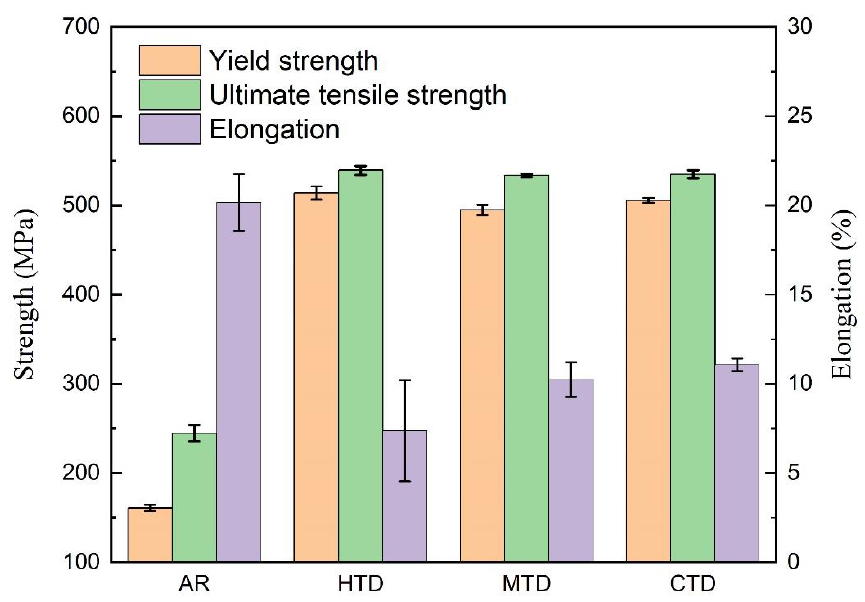
Figure 10. Stress–strain curves of T6 heat treated 7085 alloys under different deformation conditions.